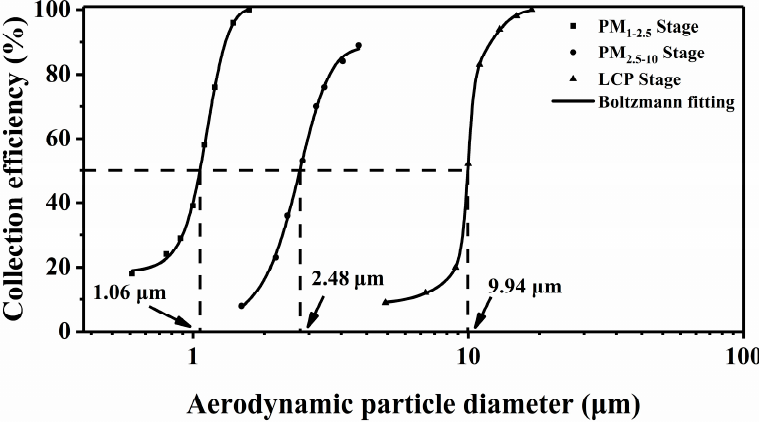
Figure 10. Particle collection efficiency curves of the cascade impactor simulated by COMSOL MULTIPHYSICS.